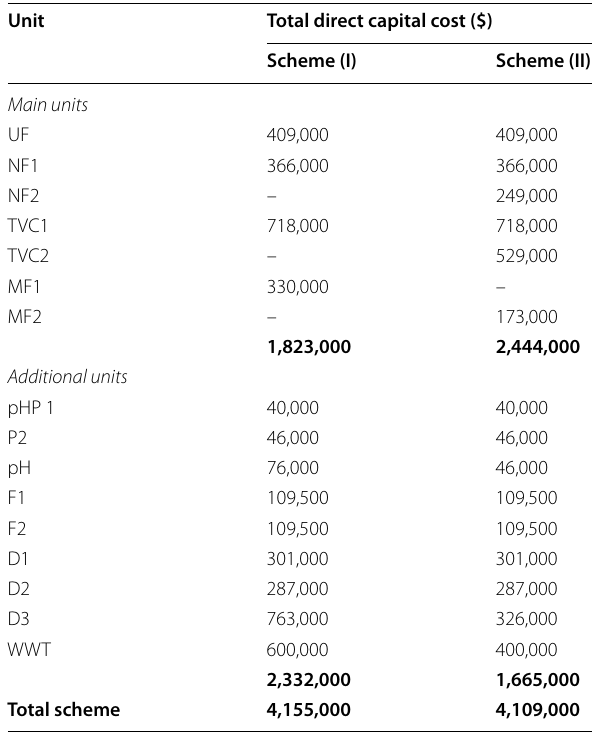
Table 5 Total direct costs for the main and additional units in the developed schemes based on 1000 m 3 /d of rice straw